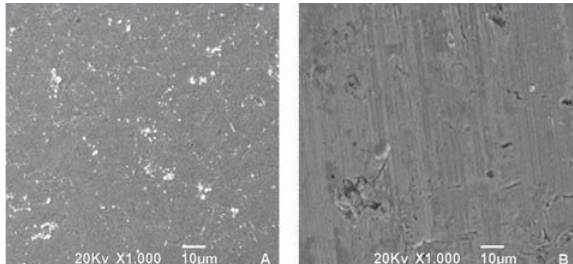
Figure 6- Scanning electron microscopy micrograph showing surface topography of MB slot (associated with SS wire) before (A) and after (B) mechanical traction